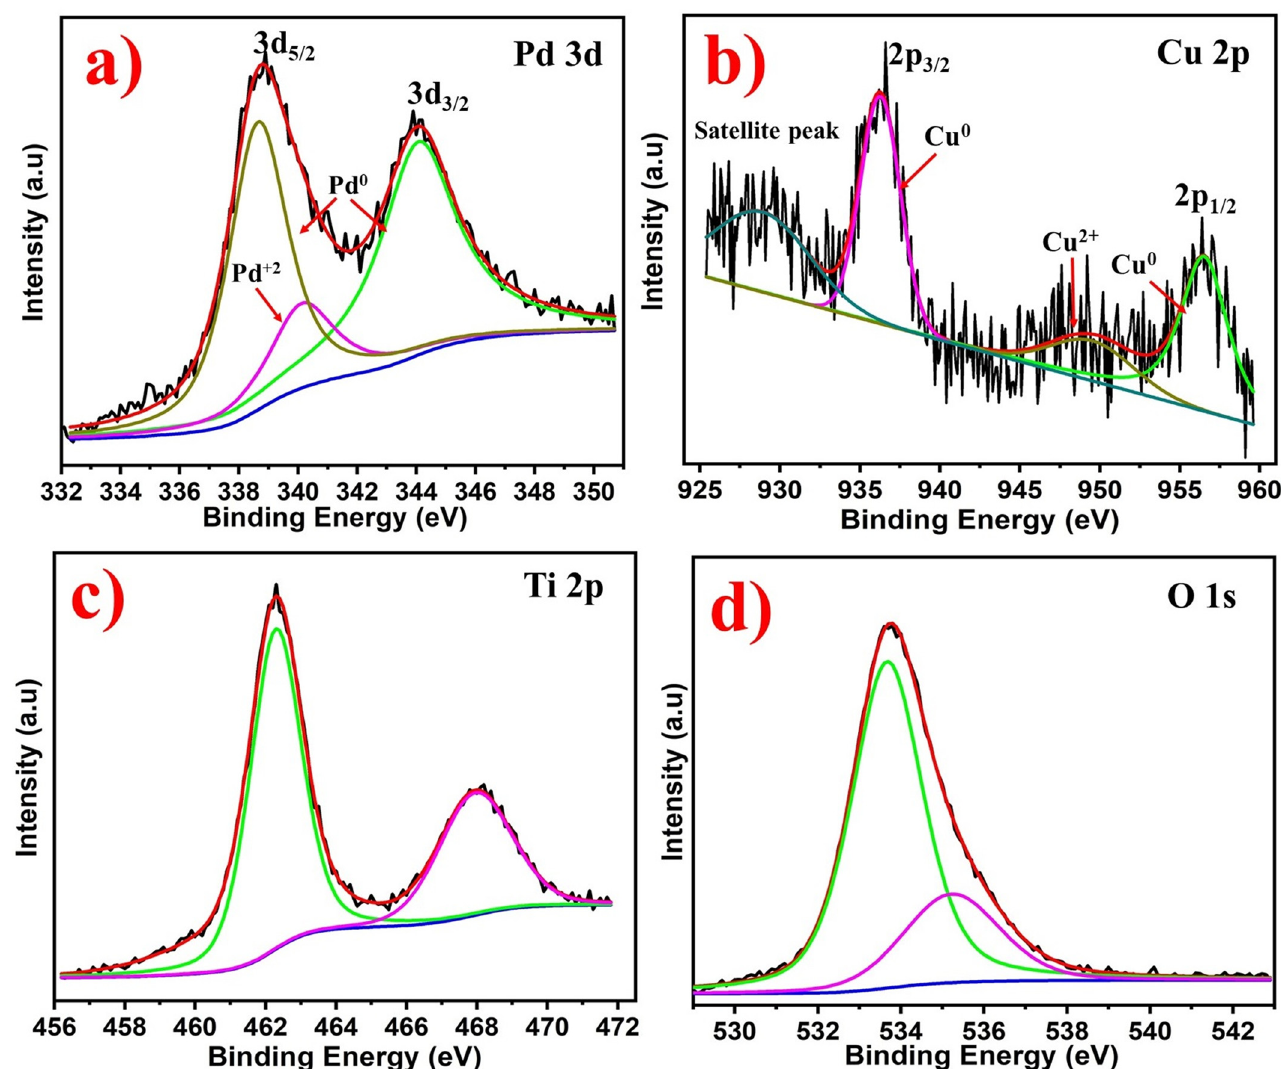
Figure 3. ( a ) Pd 3d, ( b ) Cu 2p, ( c ) Ti 2p, and ( d ) O 1s XPS spectra of Pd 2 Table 1. ICP-AES results of Pd 2 Cu/P25 photocatalyst.